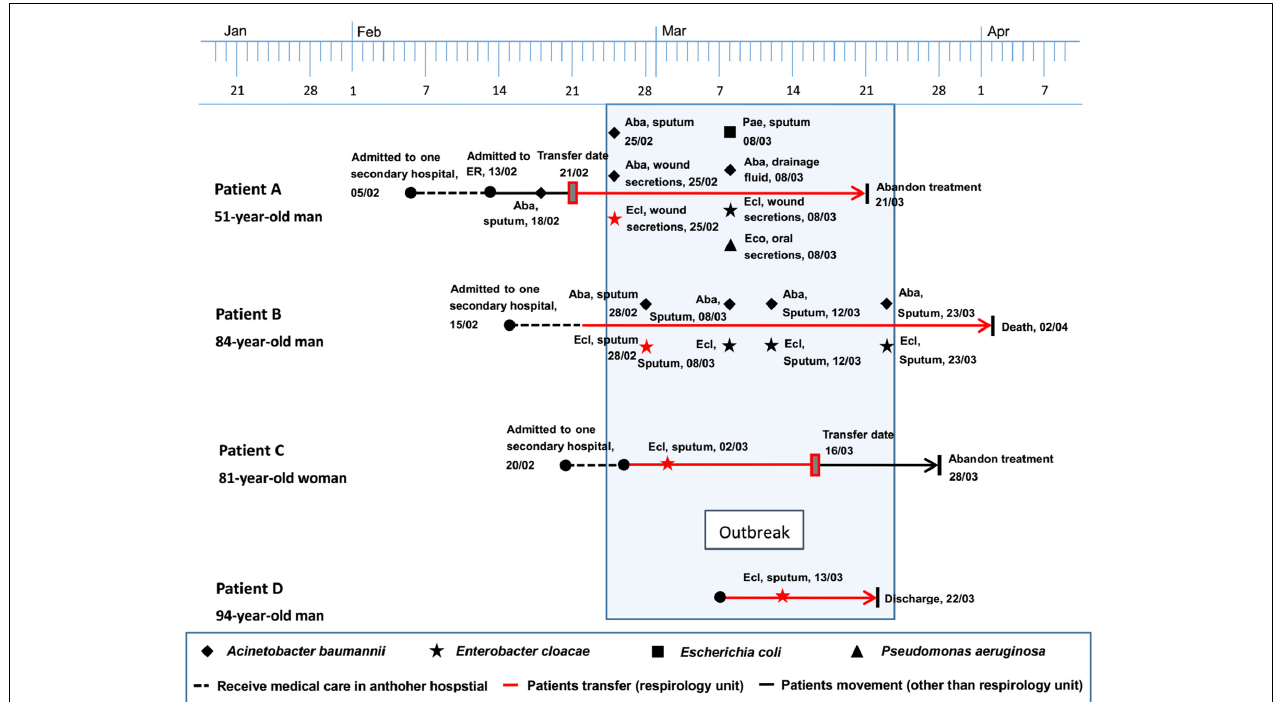
FIGURE 4 | Timeline of the NDM-1-producing E. cloacae outbreak cases.